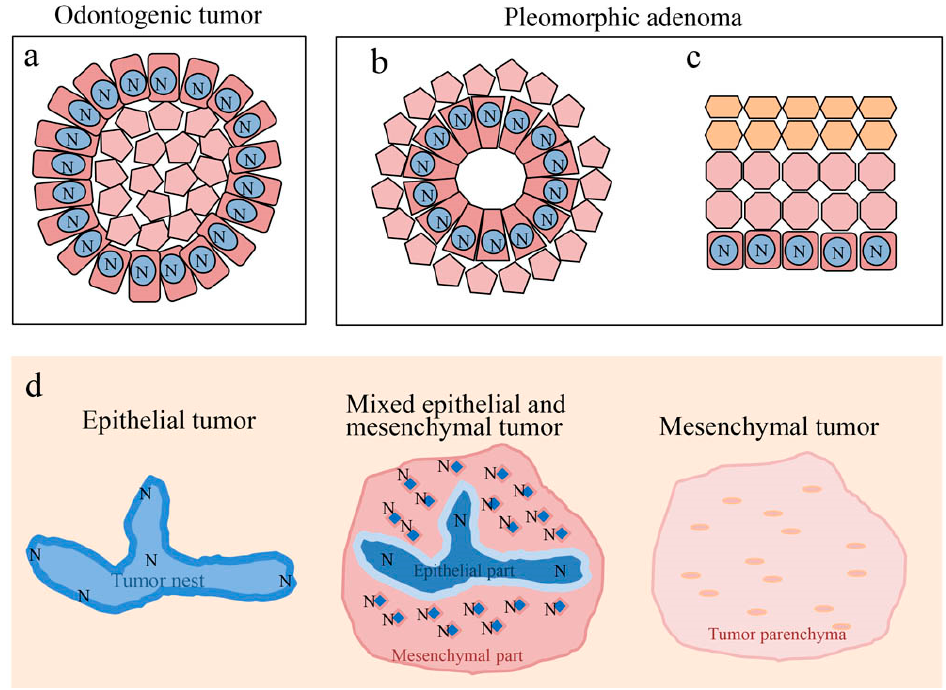
Figure 10. Notch signaling in cell di ff erentiation of oral tumors. ( a ) Di ff erentiation of ameloblast-like cell. ( b ) Di ff erentiation of ductal epithelium. ( c ) Di ff erentiation of squamous epithelium. ( d ) Notch signaling is involved in epithelial-mesenchymal interactions of odontogenic tumors. N: Notch expression.